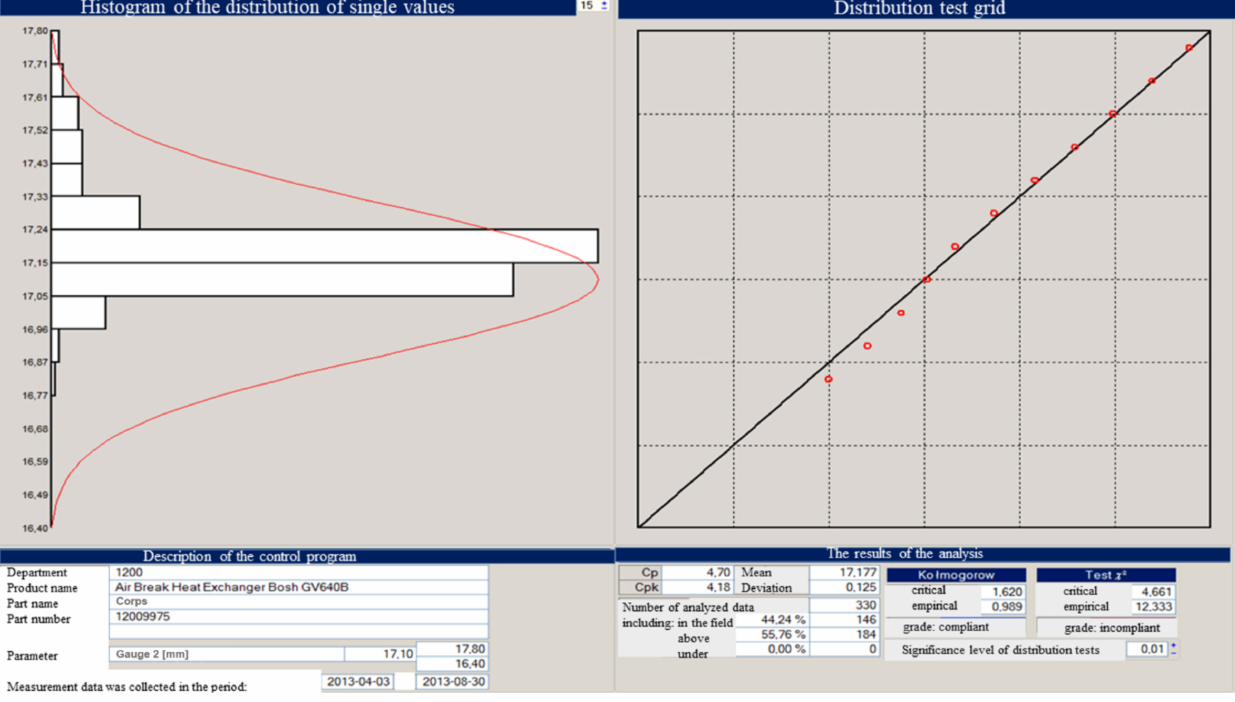
Figure 29. Distribution histogram for single